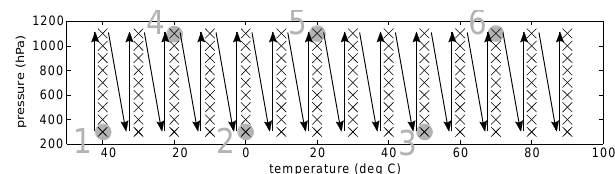
Figure 1. Six selected calibration points for digital barometric pres- sure sensors, chosen from a reference data set (marked with × ); recorded data is in ascending order to avoid temperature hysteresis